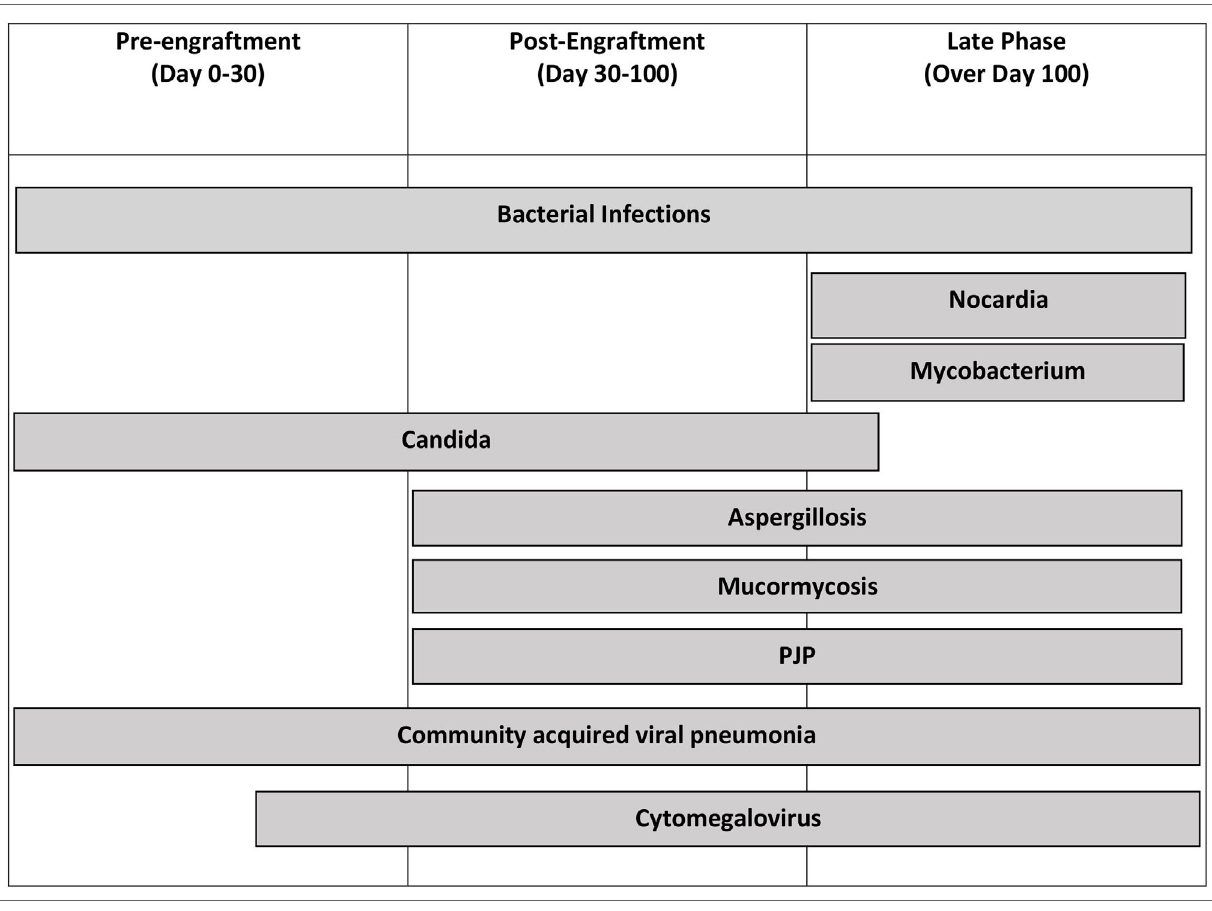
TABLE 4 | Infectious complications and the most common times in which